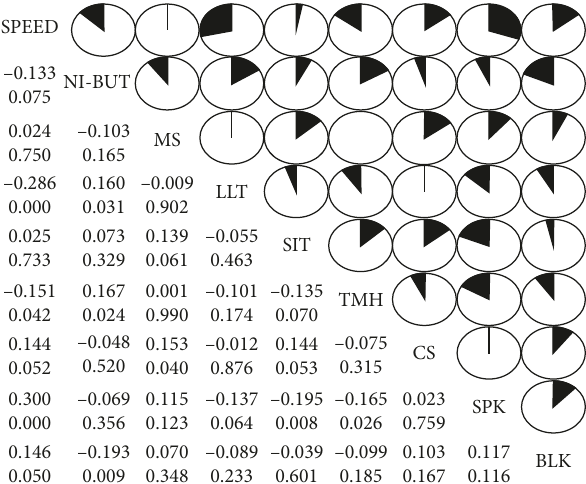
Figure 3: A correlogram illustrates the strength of correlations between ocular surface clinical parameters in the diabetic patients. In the pie graphs, the clockwise direction indicates a positive correlation and counterclockwise direction a negative correlation. For the numbers on the left of the pie graph, the upper one indicates the correlation coefficient and the lower one the P value (SPEED, standard patient evaluation of eye dryness; LLT, lipid layer thickness; NI-BUT, noninvasive tear film break-up time; TMH, tear meniscus height; MS, total percentage of meibomian gland dropout area in upper and lowers eyelids; SPK, superficial punctate ker- atopathy score; CS, corneal sensitivity; SIT, Schirmer I Test (total tear